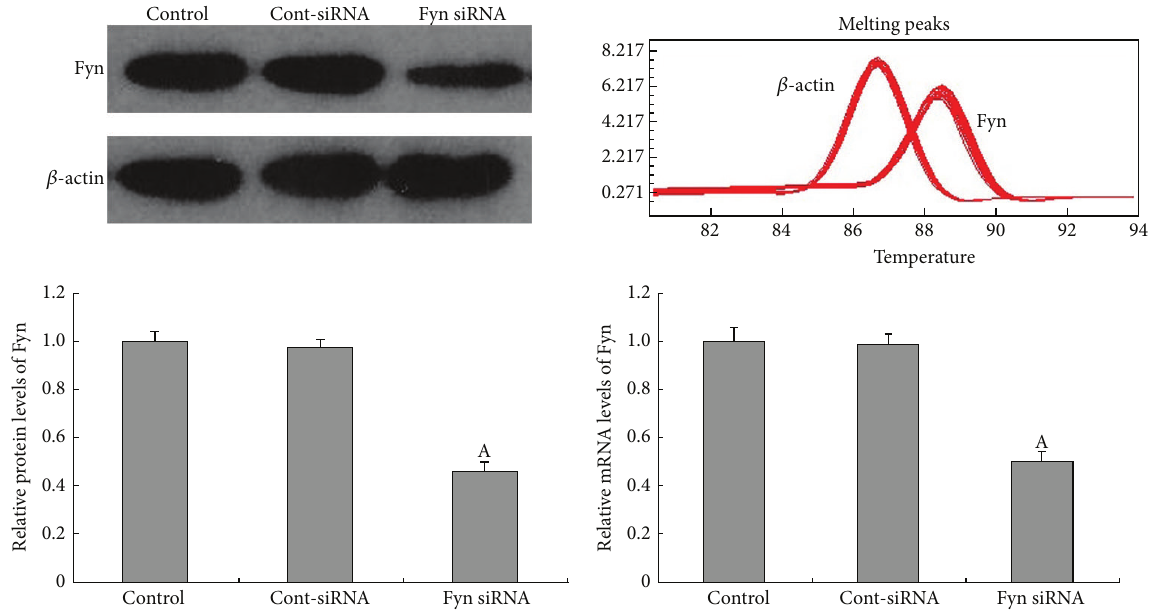
Figure 6: Fyn siRNA gene knockdown effects on Fyn expression in podocytes by western blotting and quantitative real-time PCR. A 24- hour transfection with Fyn siRNA notably reduced the expression of Fyn in cells treated with 5.5 mM glucose on both protein and mRNA levels (lane 3). Fyn expression was not significantly altered in podocytes transfected with Cont-siRNA for 24 hours (lane 2) compared with untransfected cells treated with 5.5 mM glucose (lane 1). Values denote the mean ± SD; A 𝑃 < 0.05 versus 5.5 mM glucose.